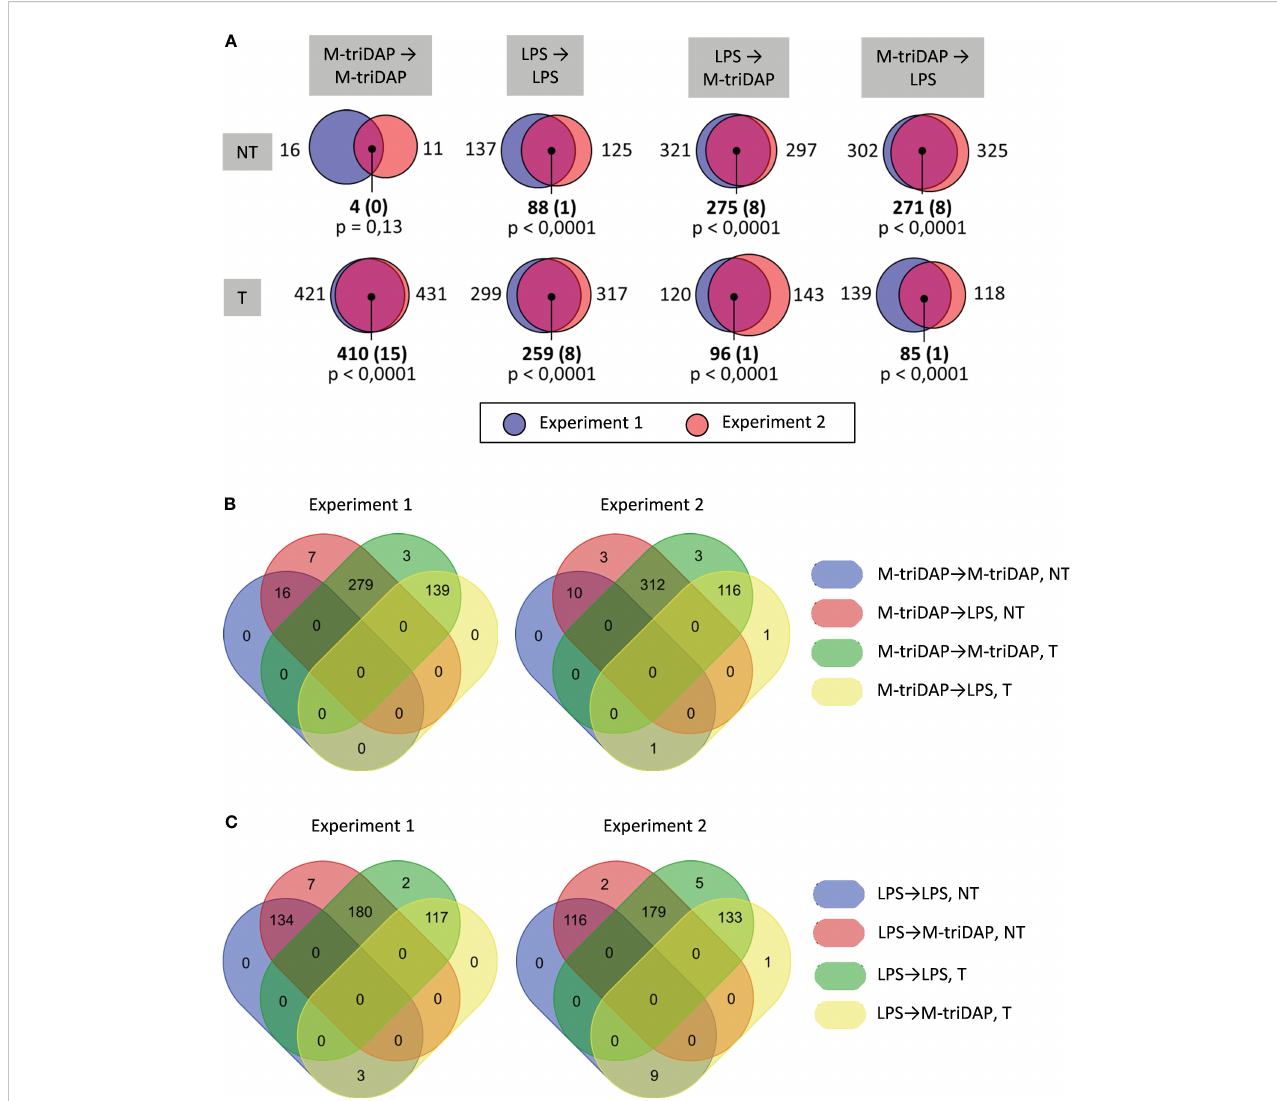
FIGURE 8 Intersections of T and NT gene sets identi fi ed in RNA-seq experiments. Only 446 genes inducible in naïve macrophages both by LPS and by M-triDAP in both RNA-seq experiments after 1 and/or 4 h of stimulation are included. (A) Sizes of T and NT gene sets identi fi ed in RNA-seq experiment 1 and 2 upon different stimulation sequences, and their intersections. (B) Venn diagrams showing intersections of T and NT gene sets upon M-triDAP ➔ M-triDAP and M-triDAP ➔ LPS stimulation. (C) Venn diagrams showing intersections of T and NT gene sets upon LPS ➔ LPS and LP ➔ M-triDAP